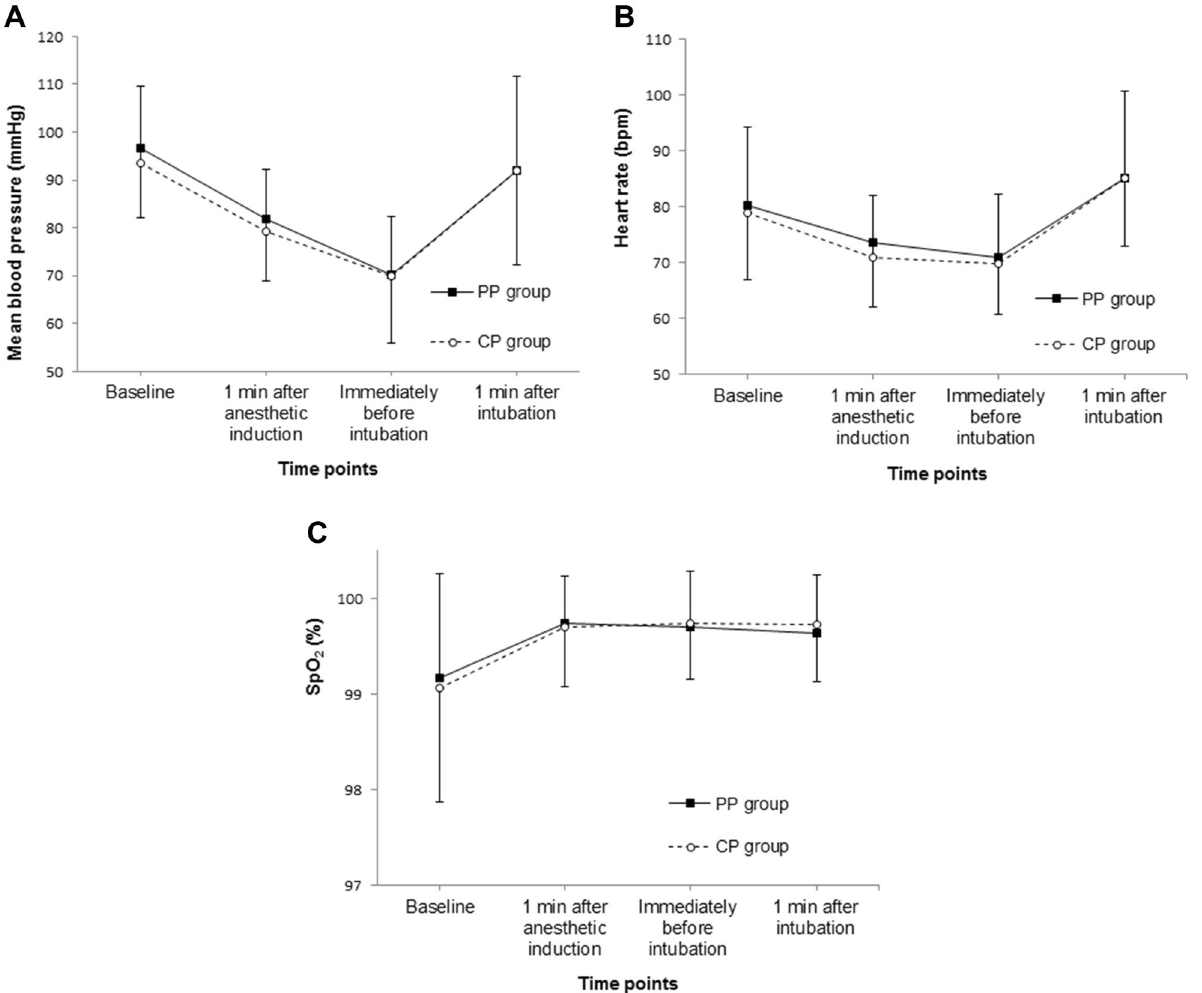
Figure 3. Changes of hemodynamics and saturation before and after intubation. SpO 2 saturation via peripheral pulse oximetry, PP group paratracheal pressure group, CP group cricoid pressure group.